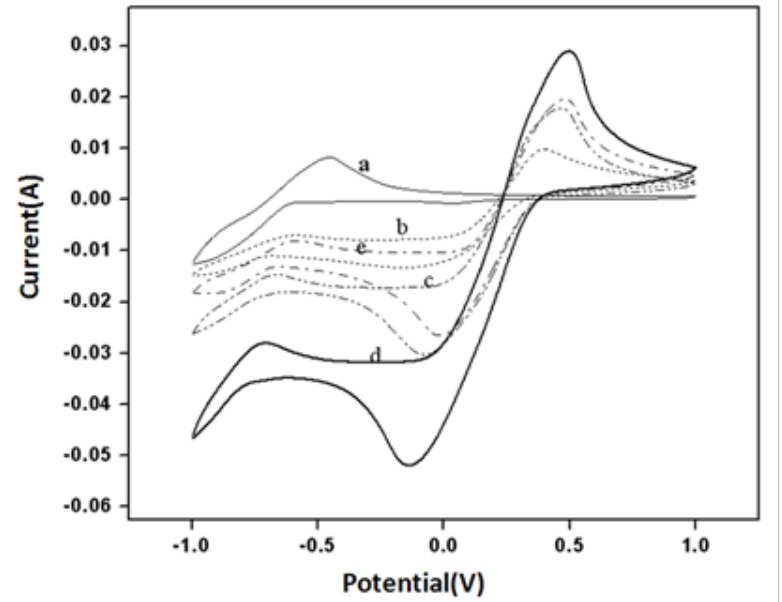
Figure 4. ( a ) pure BP in PBS; ( b ) Pure BP in K 3 Fe(CN) 6 ; ( c ) aMWCNT BP with in K 3 Fe(CN) 6 ; ( d ) BP1 (aMWCNT with gold) in K 3 Fe(CN) 6 ; ( e ) BP1 in K 3 Fe(CN) 6 with HRP-GOx.